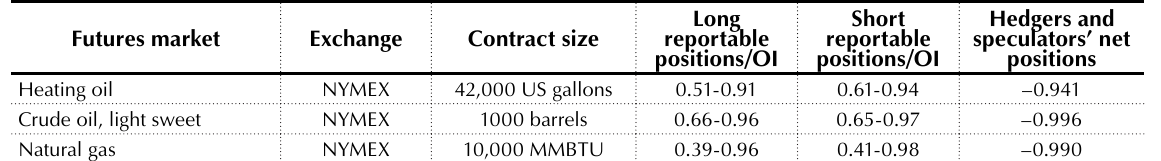
Table 1. Contract specifications